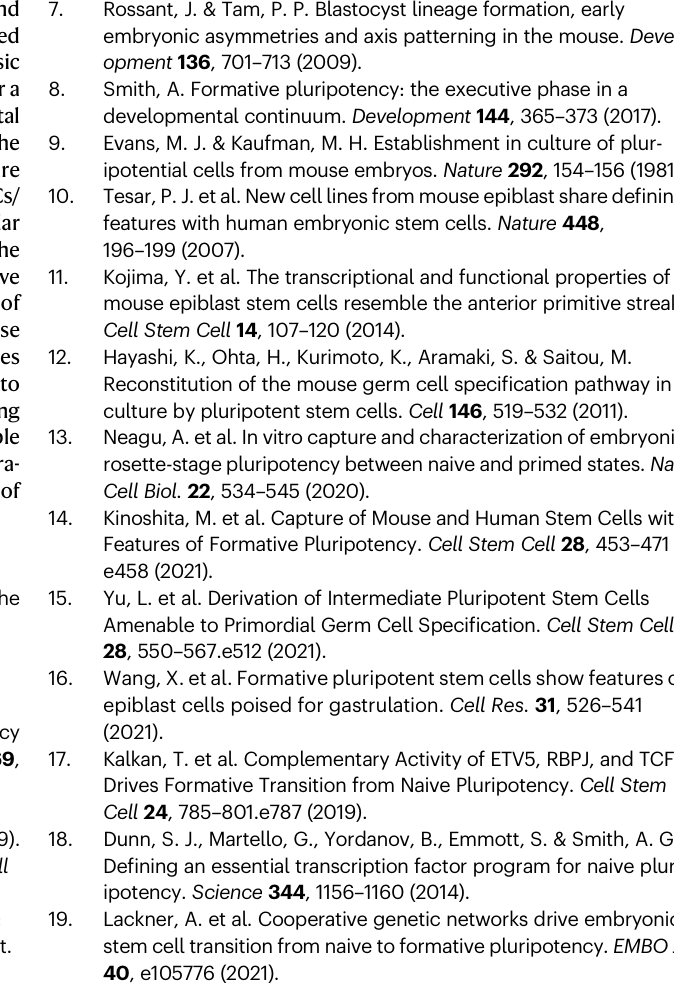
molecules (signalling pathway, TF and epigenetic factors) to exert different func- tions in closely-related stem cell con fi